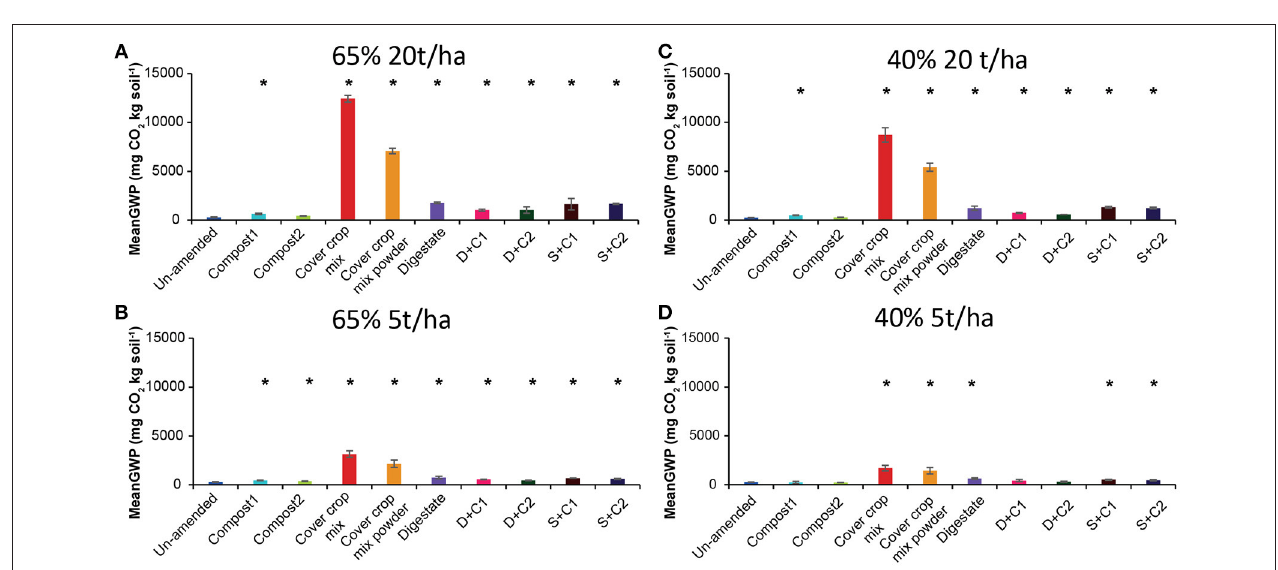
FIGURE 4 | Mean global warming potential (GWP) over the period of 28 d in un-amended clay soil and after amendments with compost1, compost2, CC residues mixtures, digestate, digestate + compost1, digestate + compost2, sewage sludge + compost1, and sewage sludge + compost2 (mean ± SD; n = 3) at (A) high amount (20 t/ha) and high water content (65%), (B) low amount (5 t/ha) and high water content, (C) high amount and low water content (40%), and (D) low amount and low water content, derived from the cumulative CH 4 ( Supplementary Figure 1 ), CO 2 ( Supplementary Figure 2 ), and N 2 O ( Supplementary Figure 3 ) fluxes. Asterisk (*) indicate significant differences in the GWP between the soils with organic amendments and the un-amended soil within the four separate superordinate treatments (ANOVA: P < 0.05).